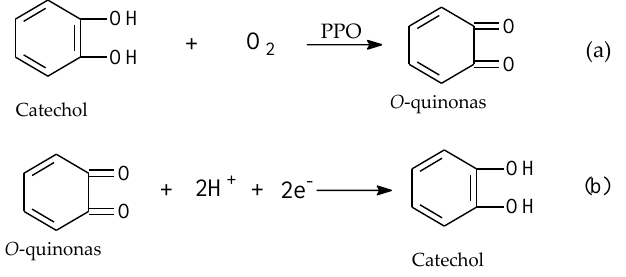
Scheme 1. ( a ) PPO-mediated oxidative catalysis of catechol; ( b ) o -quinone reduction to catechol.